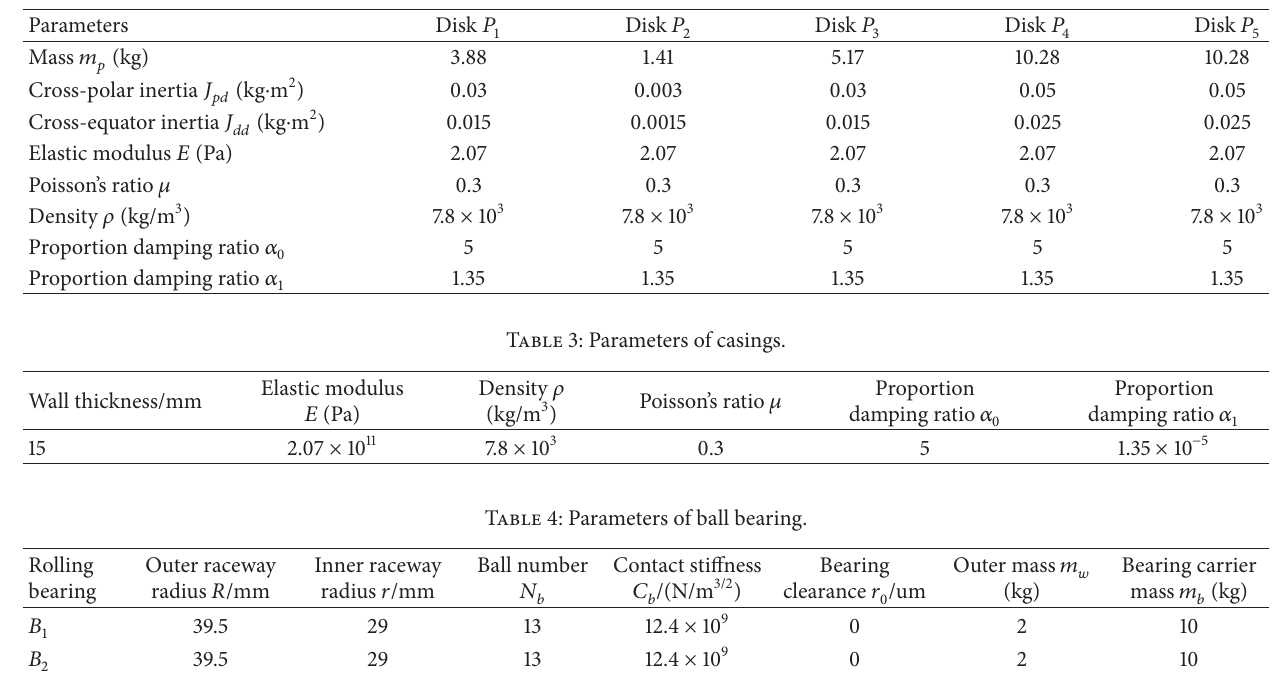
Table 2: Parameters of rotors.